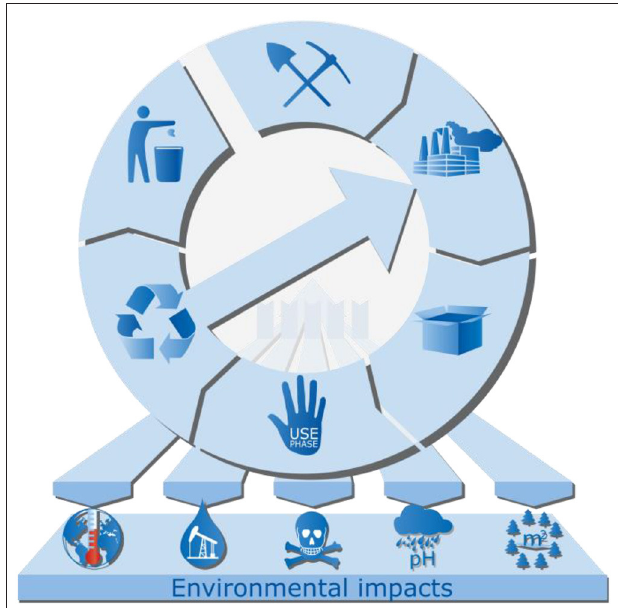
FIGURE 1 | The holistic approach of life cycle assessment accounts for environmental impacts associated over the entire life cycle with all stages of product’s life cycle (circle in the middle).